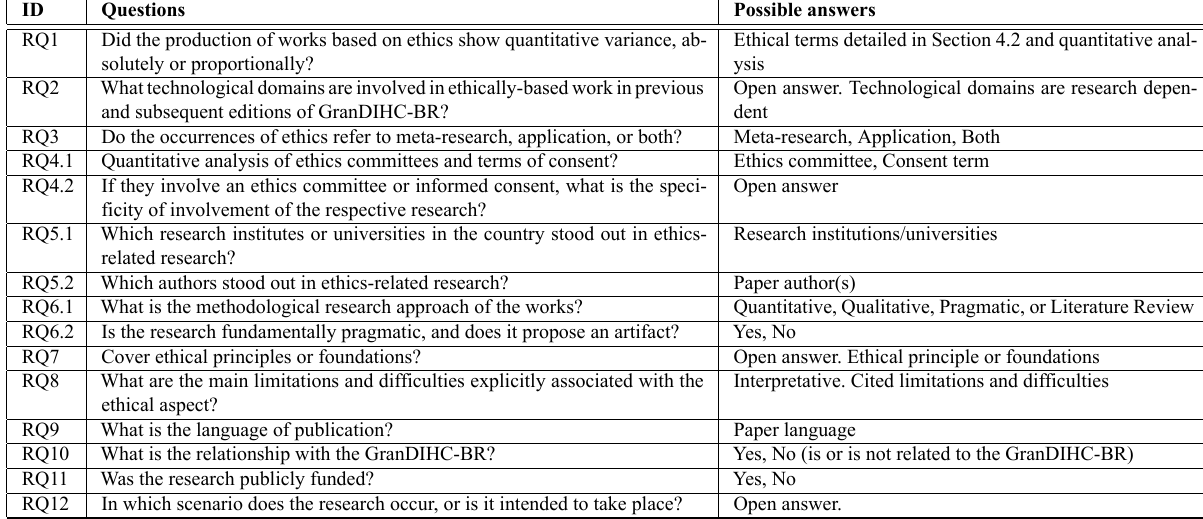
Table 1. Research sub-questions and possible answers